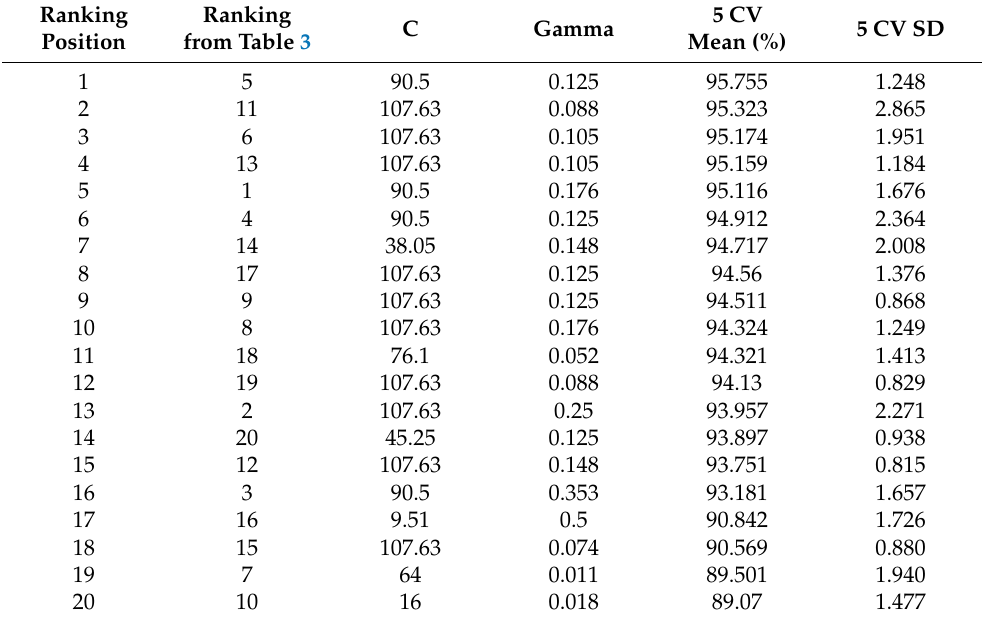
Table 7. Top 20 ranking for multiple wavelength usage for white eggshells with hyperparameter optimization and decreased C parameter